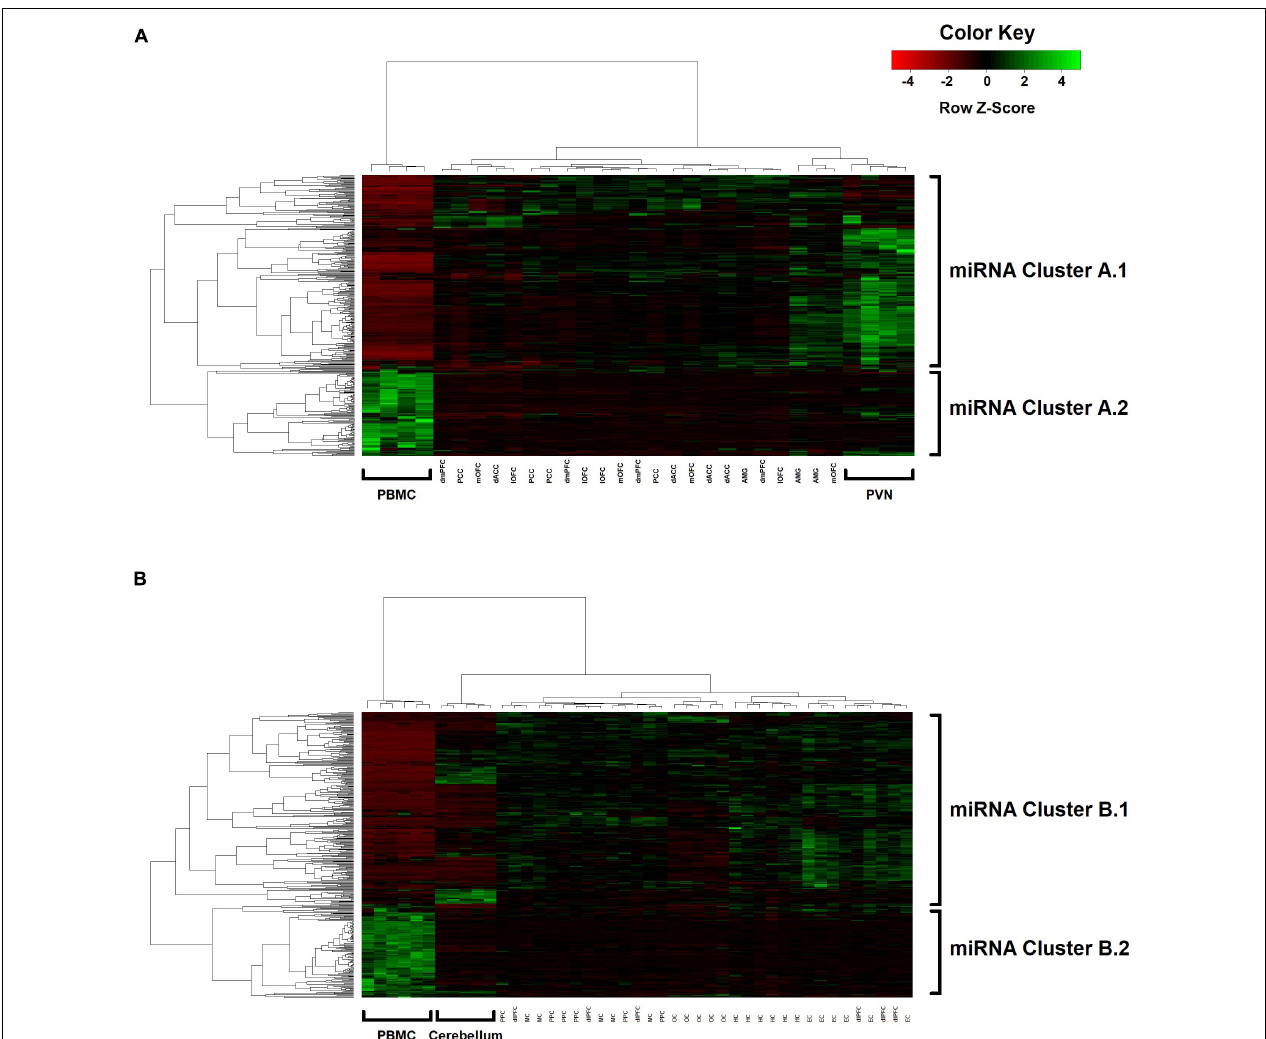
FIGURE 3 | Two-way UPGMA clustering of miRNA expression levels, with aligned heatmap of Z-scores (columns represent the various blood and brain samples; rows represent the 362 miRNAs) in (A) Group A animals and (B) Group B